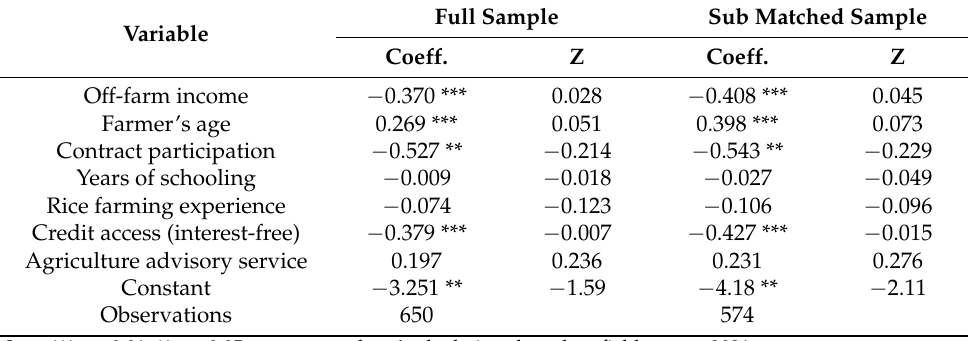
Table 4. Inefficiency estimates for organic rice production in Punjab, Pakistan. Full Sample Sub Matched Sample Variable Coeff. Z Coeff. Z